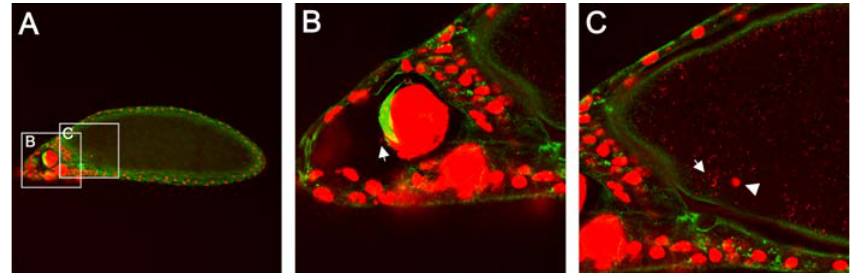
Figure 6. Wolbachia Are Transferred into the Oocyte from Nurse Cells through Cytoplasmic Dumping Wolbachia and host DNA are red (propidium iodide), and cell cortex and ring canals are green. (A) A stage 12 egg chamber nearing completion of cytoplasmic dumping. (B) Higher magnification of nurse cell remnants. Only a small number of Wolbachia are present in remaining nurse cell cytoplasm. White arrow indicates a few Wolbachia near a nurse cell nucleus. (C) Higher magnification of the anterior region of the oocyte. Nearly all Wolbachia have been ‘‘ dumped ’’ into the oocyte. White arrow indicates Wolbachia, and white arrowhead points to the oocyte nucleus. DOI: 10.1371/